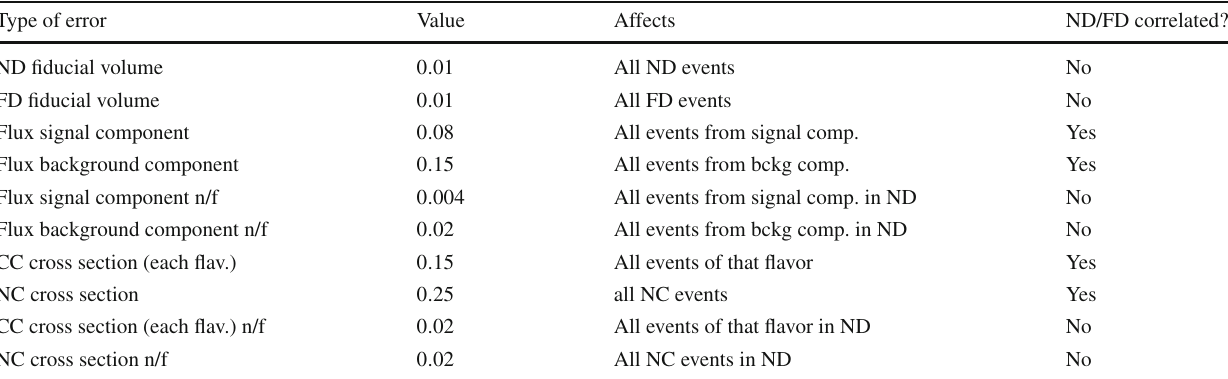
Table 2 List of systematic errors assumed in the sterile neutrino